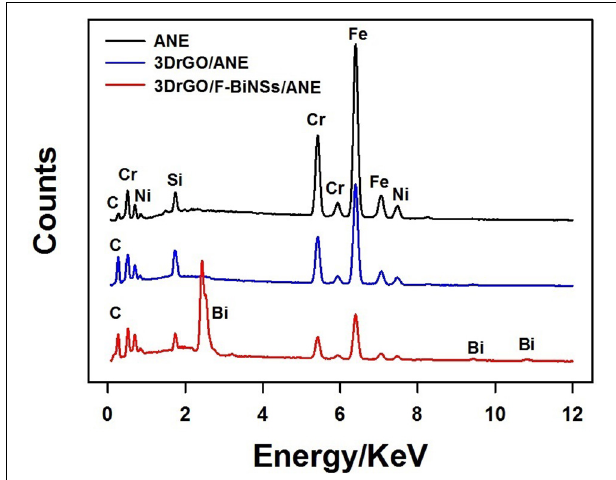
FIGURE 4 | Cyclic voltammograms (A) and linear sweep voltammograms (B) of the bare ANE, 3DrGO/ANE, and 3DrGO/F-BiNSs/ANE in 0.1 mol L − 1 acetate buffer solution with the scan rate of 50 mV s − 1 .